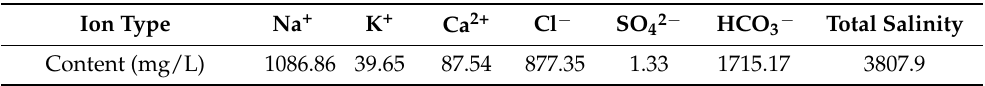
Table 3. Formation water salinity.